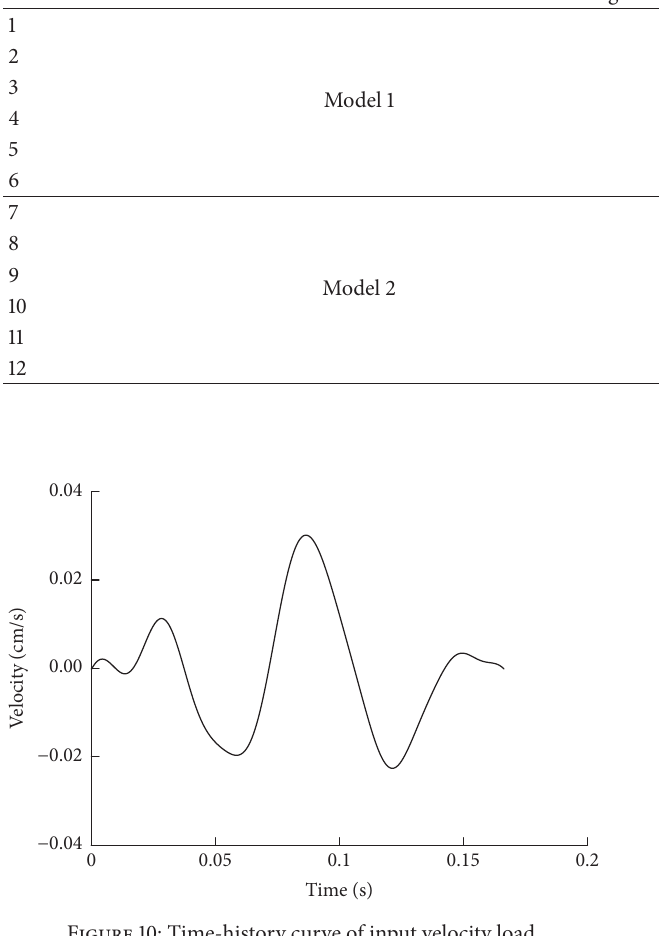
Figure 10: Time-history curve of input velocity load.